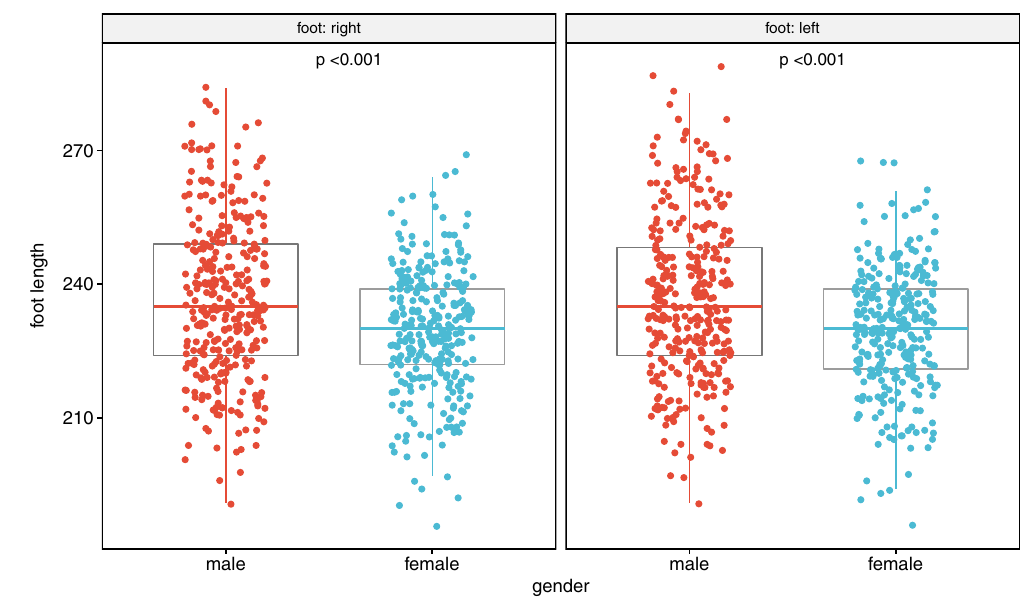
Figure 1. Dependence of foot length on gender 15,16 .